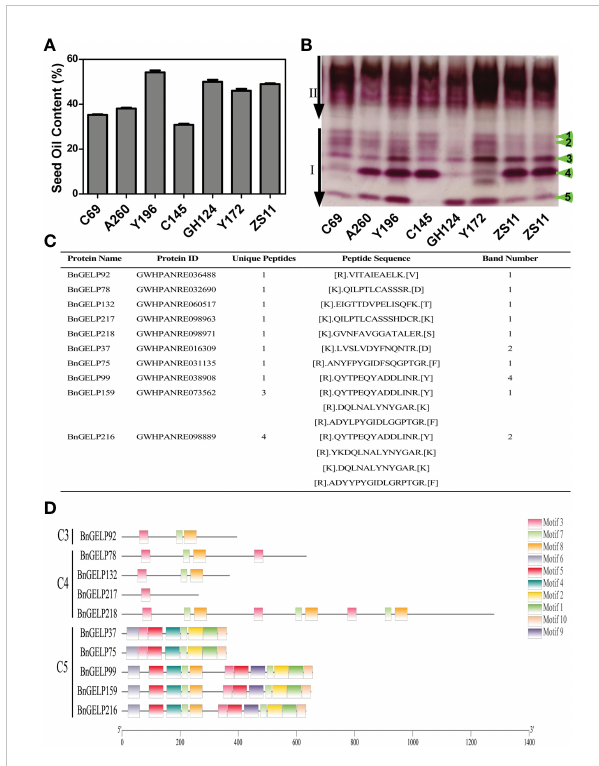
FIGURE 4 A zymogram of esterase isozymes in different B . napus materials. The seeds were from cultivar ZS11and inbred lines C69, A260, Y196, C145, GH124 and Y172. (A) Seed oil content of the B . napus materials. (B) The zymogram of esterase isozymes in different B . napus materials. (C) Mass spectrometric identi fi cation of different bands in region I of the zymogram in (B) . Selected unique proteins and the corresponding sequences are indicated. (D) Conserved motifs of the identi fi ed BnGELP proteins from region I of the zymogram. Boxes of different colors represent different